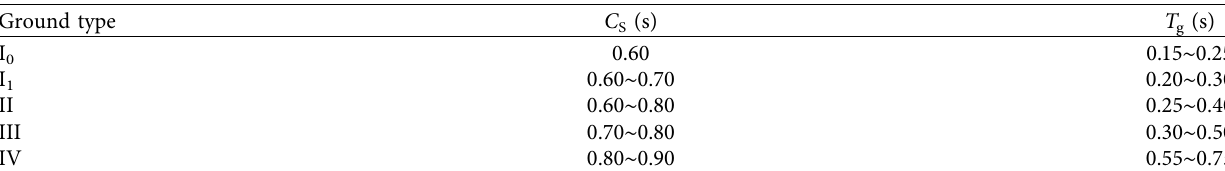
Table 3: Parameters of the vertical elastic response spectra in the Chinese